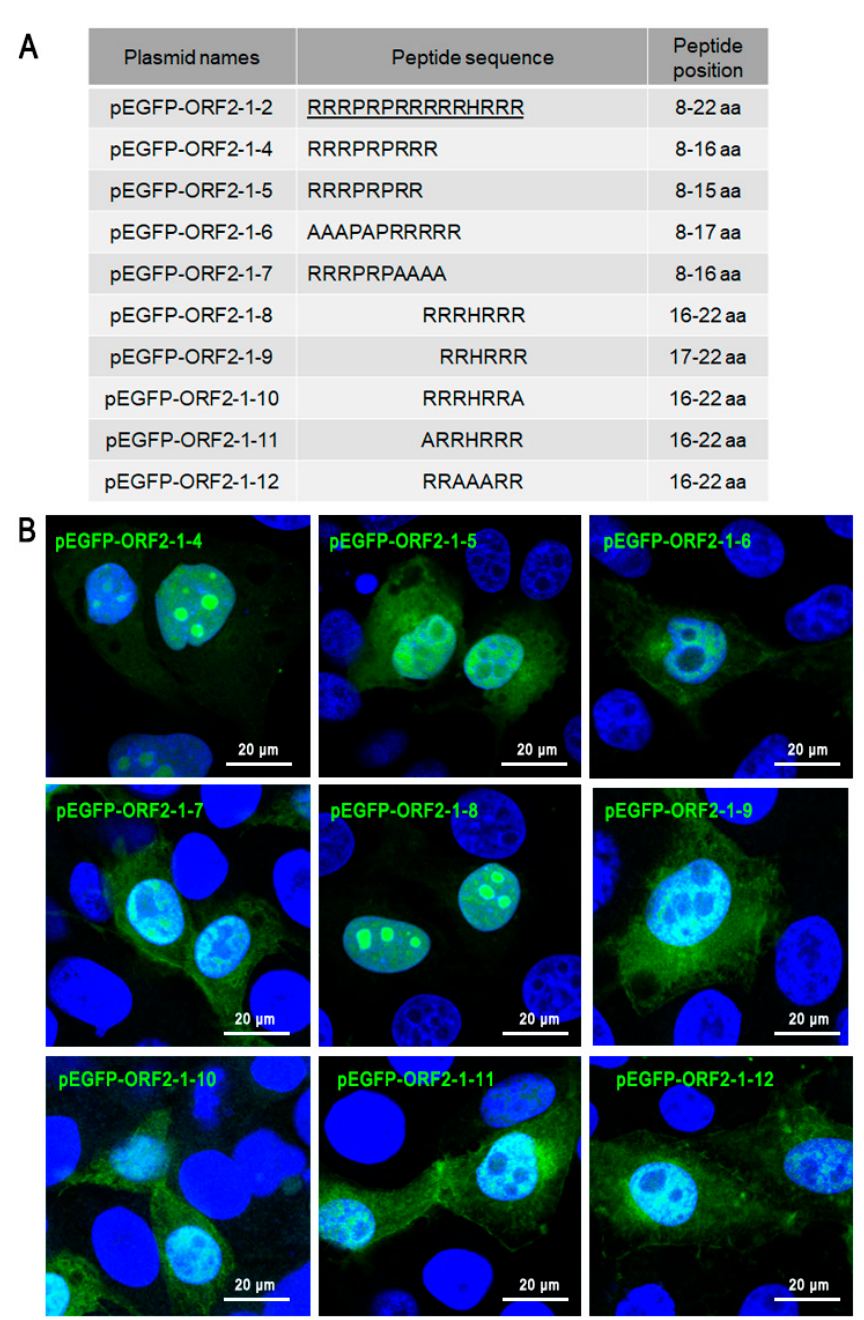
Figure 3. The main nucleolar localization signal motifs in ORF2-1-2. ( A ) Mutants of ORF2-1-2 gene were inserted into pEGFP-C3 and predicted nucleolar localization signal motifs are underlined. ( B ) PK-15 cells were transfected with plasmids, after 24 h, the cells were fixed and the localization of fusion proteins was observed by confocal microscopy. Scale bars = 20 µ